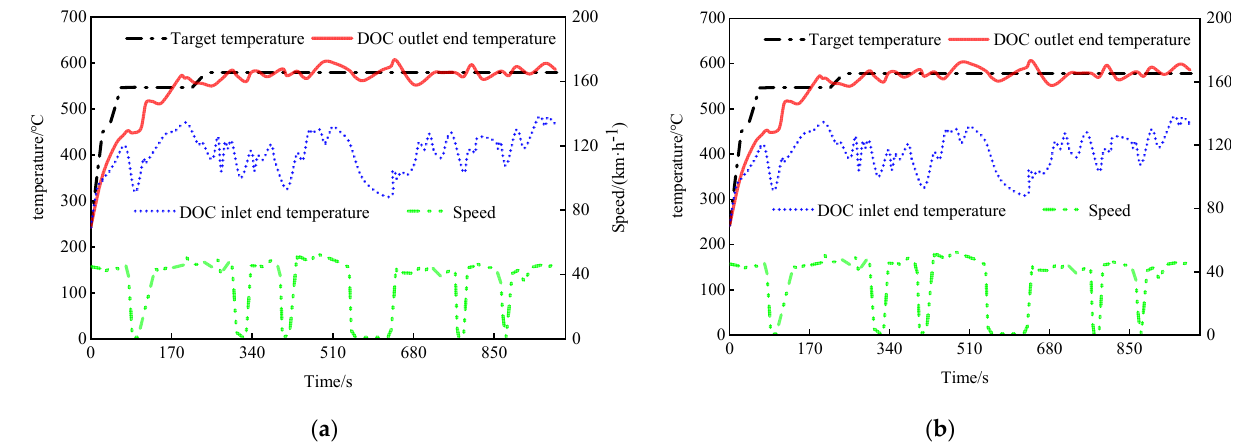
Figure 17. Testing results under city-road and suburban driving conditions; ( a ) Working conditions of the city; ( b ) Working conditions of the suburbs.